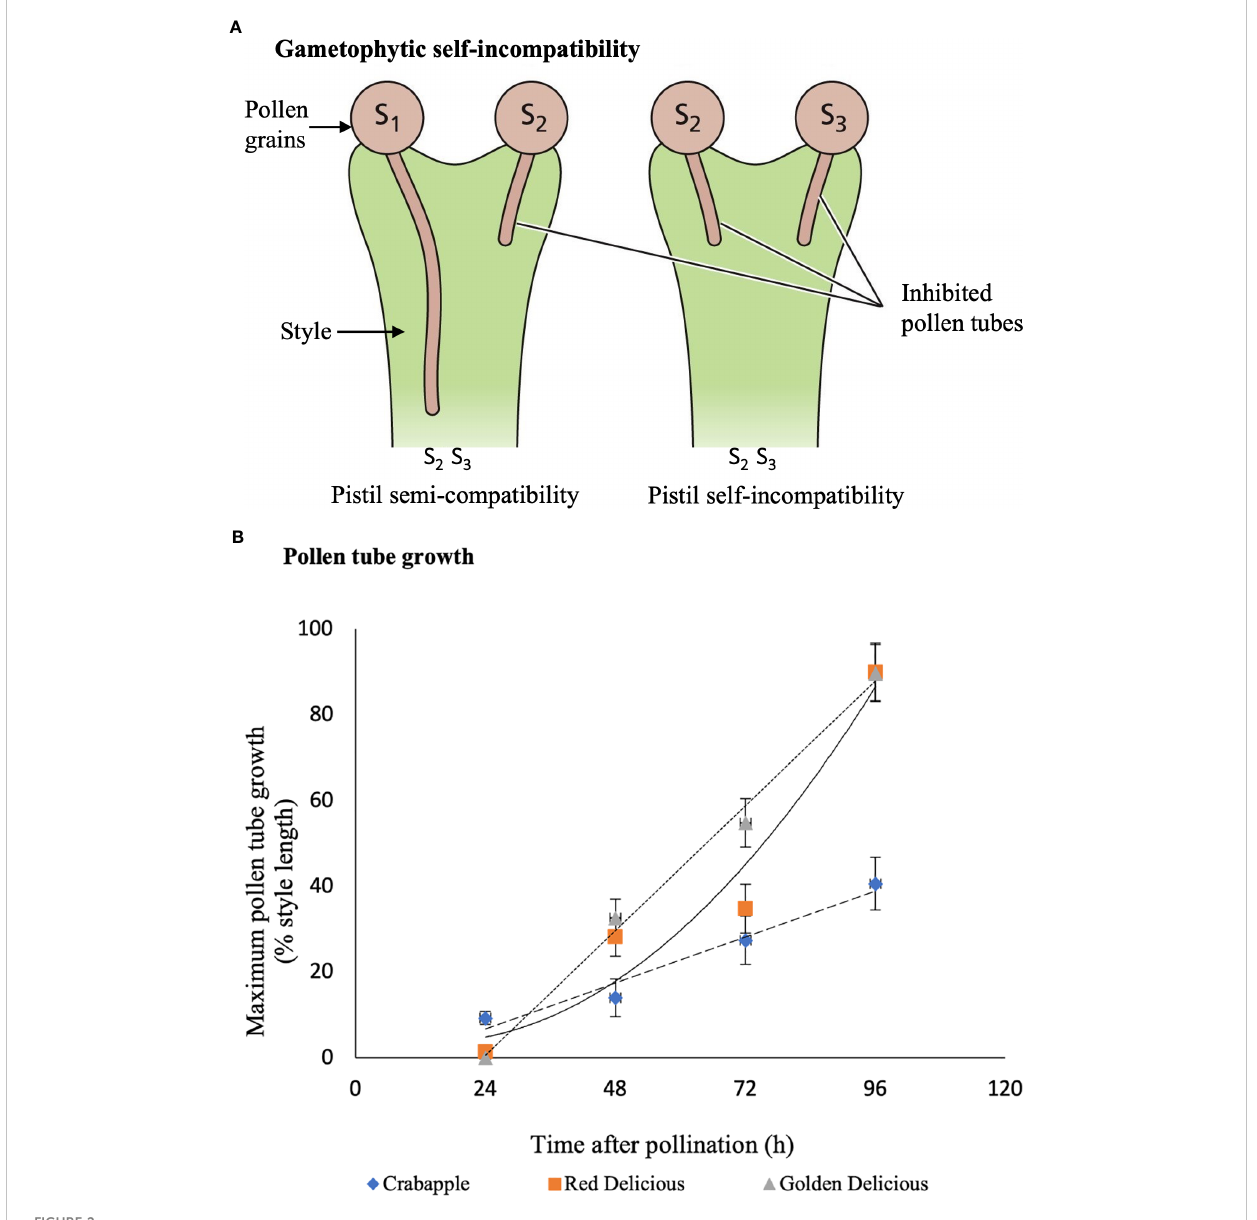
FIGURE 2 Semi-incompatibility in apple. (A) represents the gametophytic semi-incompatibility mechanism compared with self-incompatibility. During self- incompatibility, both pollen grain S-haplotypes are identical to those of the pistil, whereas in semiincompatible fl owers, only one pollen grain S- haplotype matches one of the pistil Shaplotype. (B) represents the pollen tube growth of ‘ Malus fl oribunda ’ crabapple, ‘ Red Delicious ’ , and ‘ Golden Delicious ’ pollen crossed with ‘ Honeycrisp ’ apple. Crabapple has the slowest growth rate. (A) is reproduced with permission of the Licensor through PLSclear, while (B) is data from our previous work (Jahed and Hirst